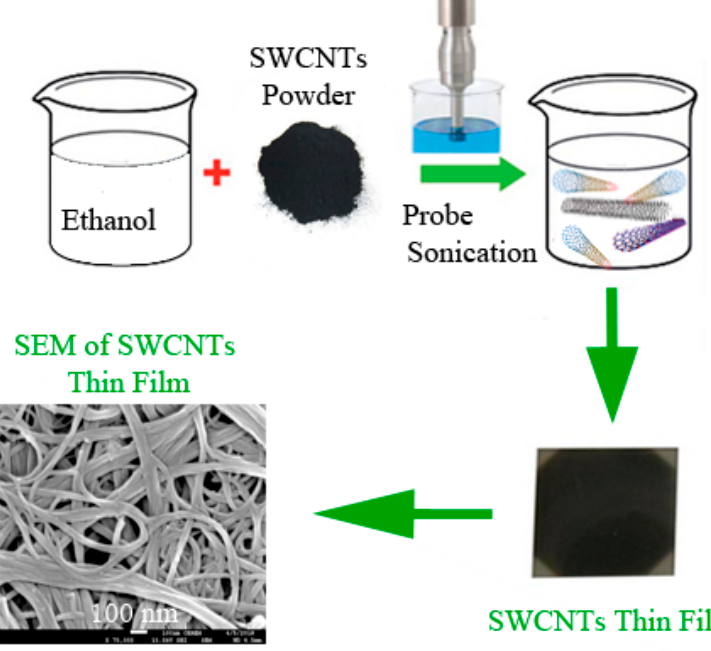
Figure 1. Schematic illustrating the process for preparation of single wall carbon nanotube (SWCNT) thin film.